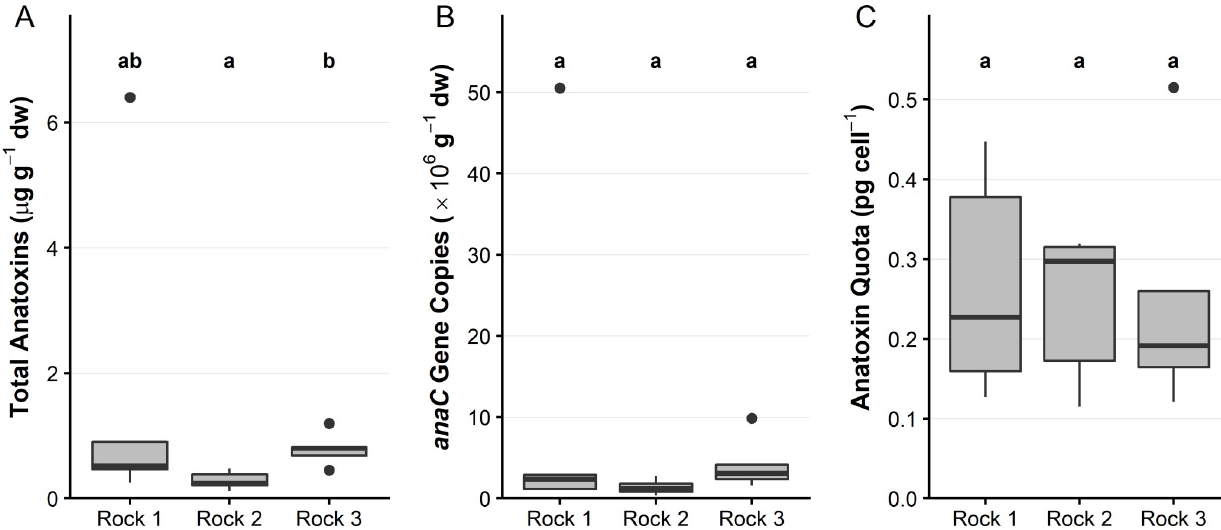
Fig 5. Anatoxin concentrations, anaC gene copies and anatoxin quota among fine-scale samples from three rocks at 4_SFE on the Eel river. (A) Summed anatoxin concentrations; (B) anaC gene copy concentrations; and (C) anatoxin quota from five mat samples collected from each of three rocks at 4_SFE. dw = dried weight. Note the different y -axis scales. See Fig 2 for interpretation of boxplots. A Kruskal-Wallis test and pairwise Wilcoxon rank sum test with a Benjamini-Hochberg adjustment was used to identify rocks that were significantly different from one another (p < 0.05), denoted by the letter above the